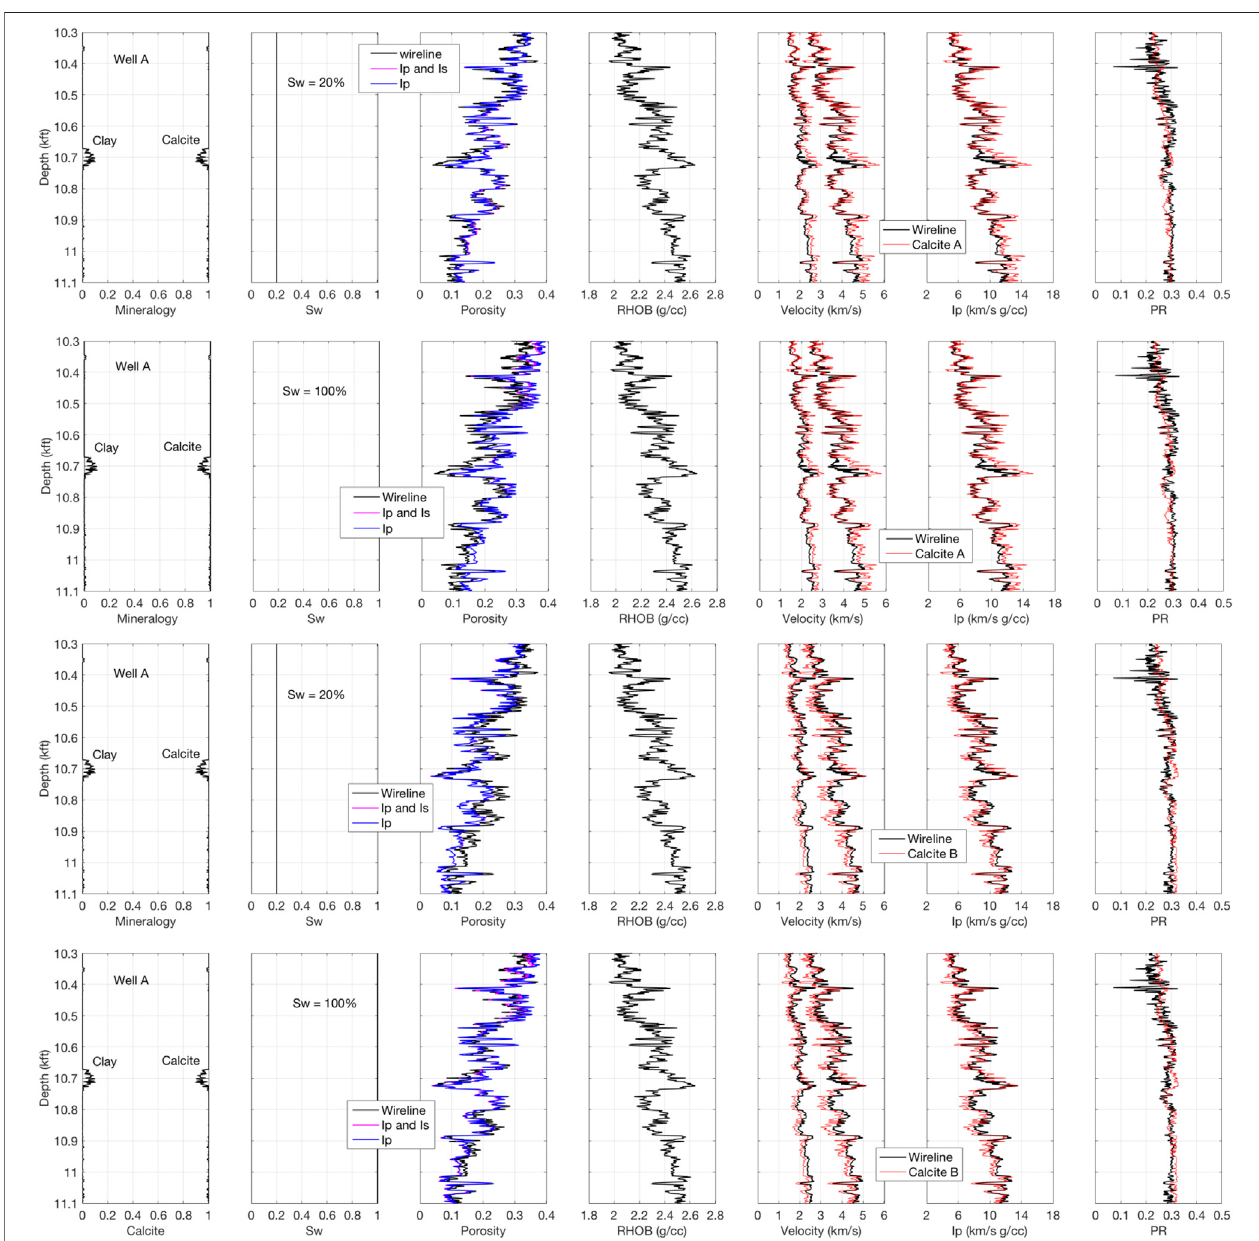
FIGURE6| Interpretationforporosityusingthefourvariantsasdescribedinthetextandalsousingonly I p and I p and I s together.Fromtoptobottom:Variants1,2, 3, and 4. The interpreted porosity curves are shown in color and described in the legends. Red curves in the elastic property frames are from the stiff-sand model using the respective